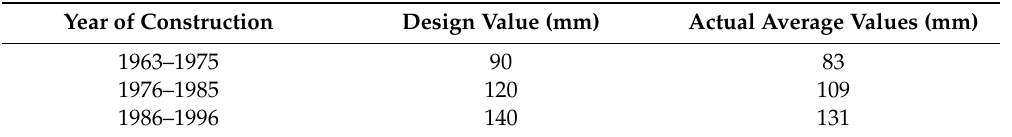
Table 4. Typical U-values for non-renovated apartment buildings in Finland and cold climate zones in Table 3. Design and actual average thicknesses of insulation layers in Finnish apartment buildings based on the year of construction [60].